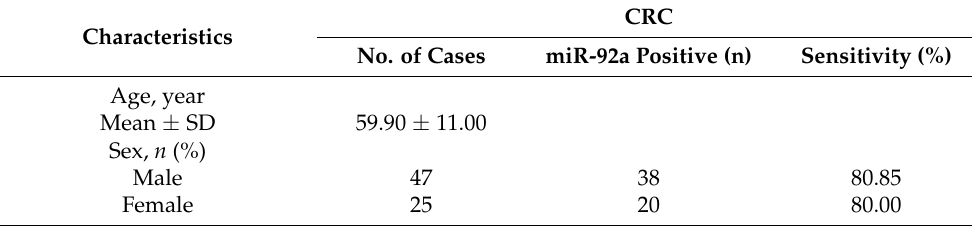
Table A2. Clinicopathological characteristics of CRC